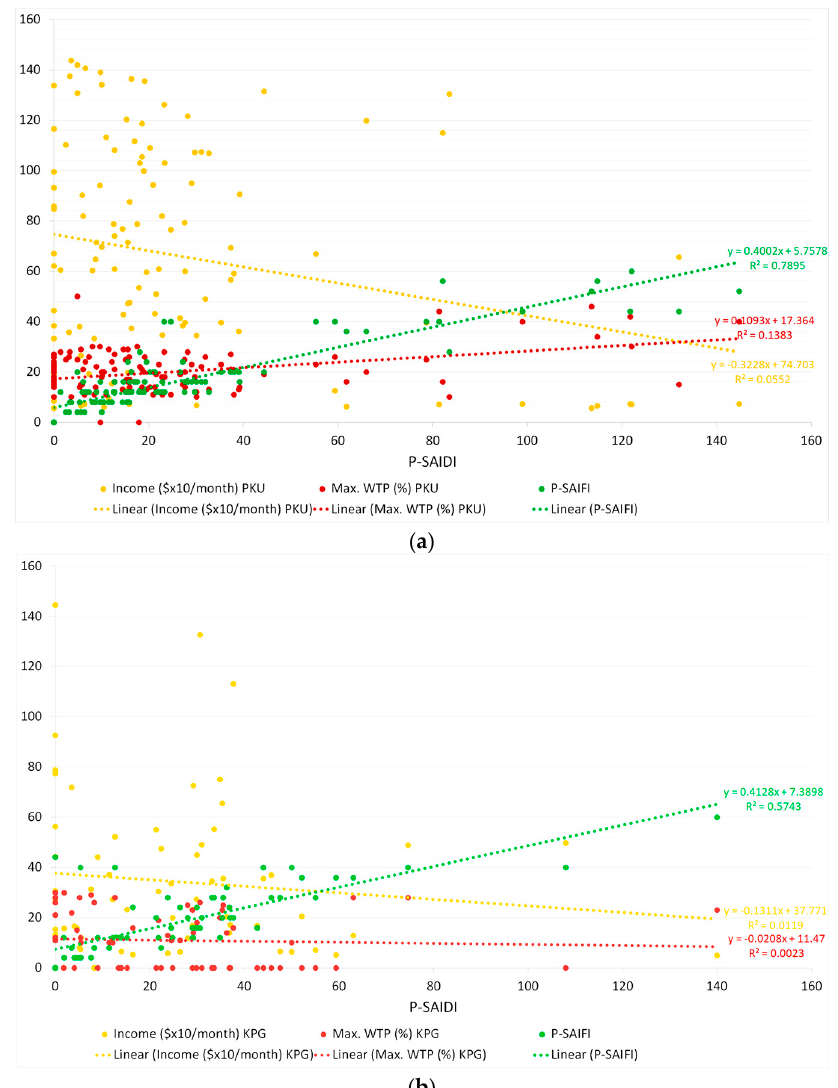
Figure 11. Correlations between P-SAIDI and P-SAIFI, the income of households, and WTP in ( a ) Pekanbaru and ( b ) Kupang.